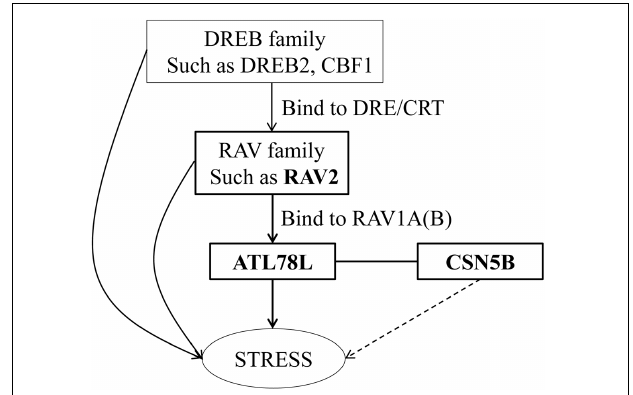
FIGURE 5 | Proposed role of ShATL78L in the plant stress signaling pathway. The model shows the genetic interactions between RAV2, ATL78L, and CSN5B genes in regulating the responses to abiotic stress in tomato.